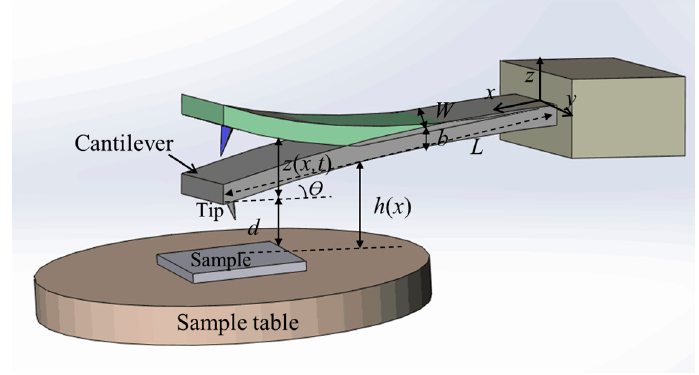
Figure 1. Schematic of simplified cantilever and sample model.